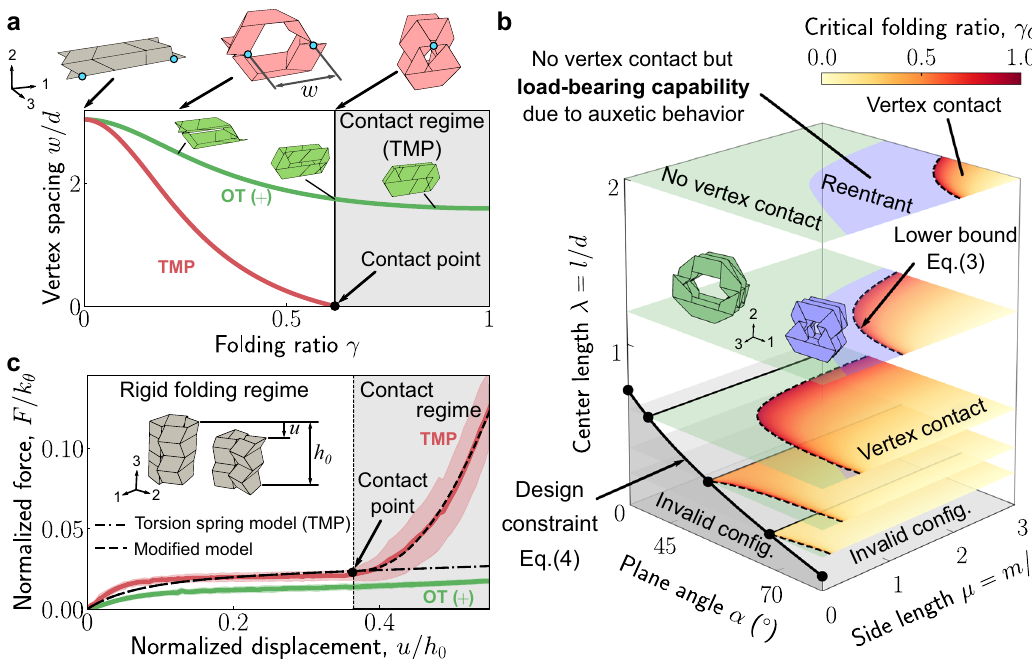
Fig. 2 Origami unit cell with self-contacting vertices. a We examine the vertex spacing ( w ) of the (red) TMP and (green) OT( + ) unit cells with ( l , m , d , α ) = (22.5, 30.0, 30.0 mm, 65°). b The 3D diagram shows the tunability of the contact point altered by the design parameters. The dashed curves indicate the boundary between rigid foldable without contacting vertex con fi gurations (green and blue-colored areas) and self-contact regimes (color intensity represents the critical contact points) bounded by Eq. (3). Here, the blue-colored regions indicate a foldable con fi guration without self-contact, but with load-bearing capability due to auxetic behavior 25 . The grey colored areas indicate the invalid design parameters. The inset illustrations show TMP unit cells with α = 45° (green: noncontacting regime) and α = 65° (blue: No self-contact, but load-bearing capability) at λ = μ = 1.2. c Compression test on the TMP and OT unit cell prototypes. The black vertical line indicates the prediction of a critical contact point from Eq. (2). We approximate the force- displacement curve for the TMP by using two models: the torsion spring origami model, in which the crease lines of the TMP are modeled as a torsion spring, whose spring constant is k θ = 43.99 Nrad − 1 (dash-dotted line); the modi fi ed torsion spring model with the repulsive force fi eld to model the vertex contact (dashed line), whose constants are k θ = 43.99 Nrad − 1 and k e = 8.889 × 10 4